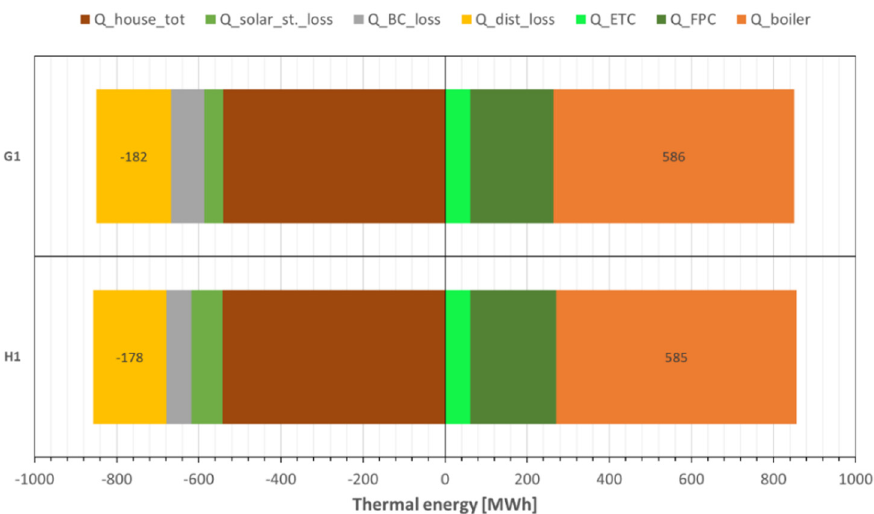
Figure 7. Energy balance; simulation results for the reference pipe combination/insulation class of the two distribution concepts modeled in this study, showing energy input is positive and output is negative.